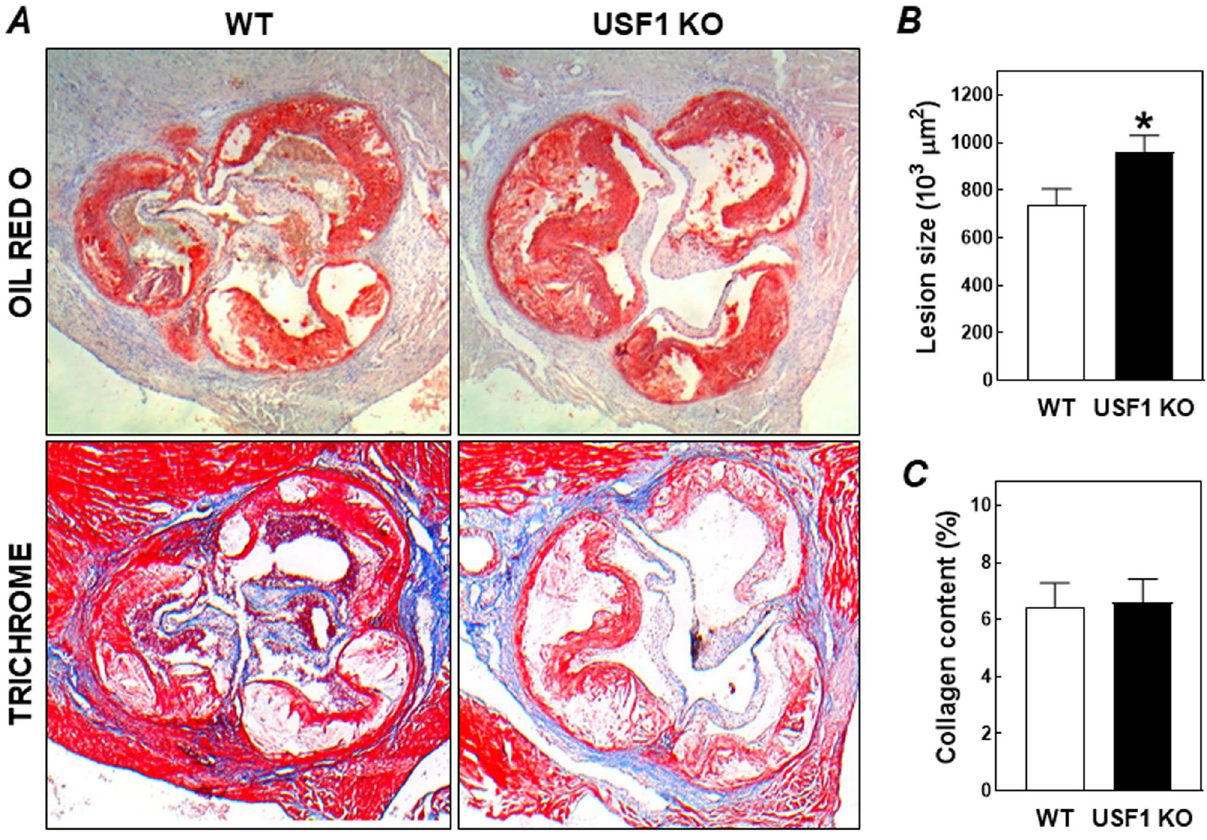
Figure 2. ( A ) Representative images of Oil red O- and Masson’s Trichrome-stained aortic root sections from LDL receptor knockout mice transplanted with bone marrow from USF1 knockout (USF1 KO) mice or their wild-type (WT) littermate controls. Quantifications of the aortic root total plaque area ( B ) and lesional collagen contents ( C ). Data represent the means ± SEM of respectively 11 WT and 16 USF1 KO bone marrow recipients. * P < 0.05 versus WT.